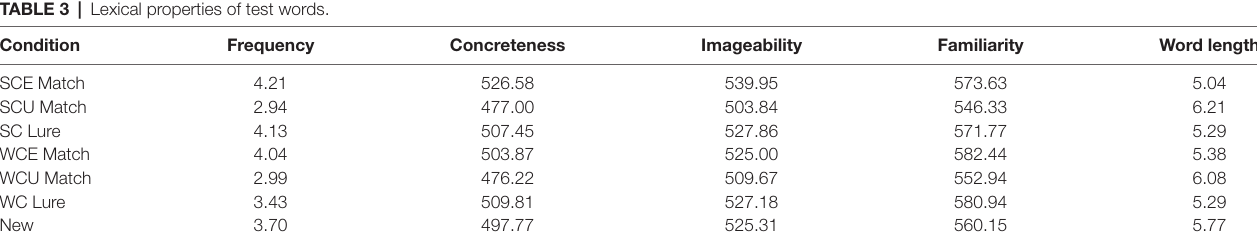
TABLE 3 | Lexical properties of test